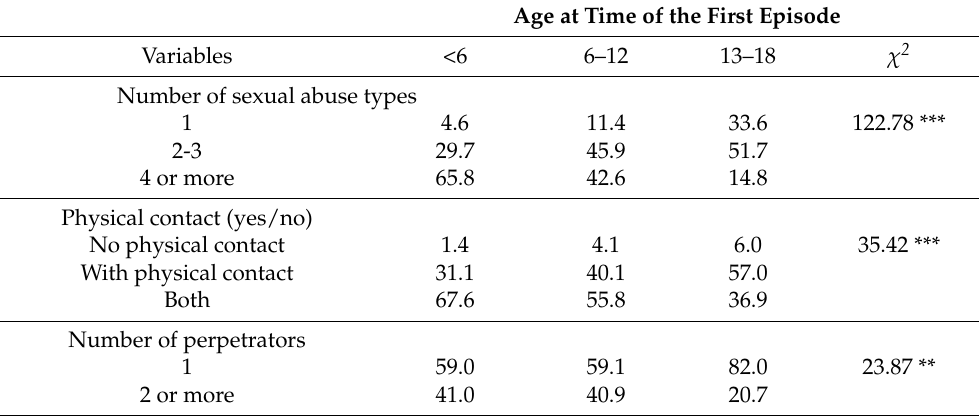
Table 3. Percentage of the number of episodes of sexual abuse, their types, and the number of perpetrators according to victim’s age at the first episode.